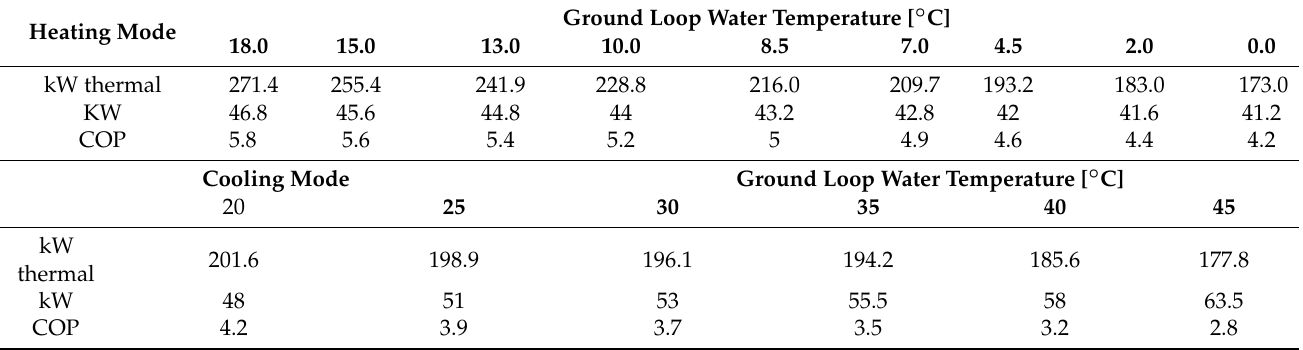
Table A2. Heating and cooling mode characteristics of the water–water heat